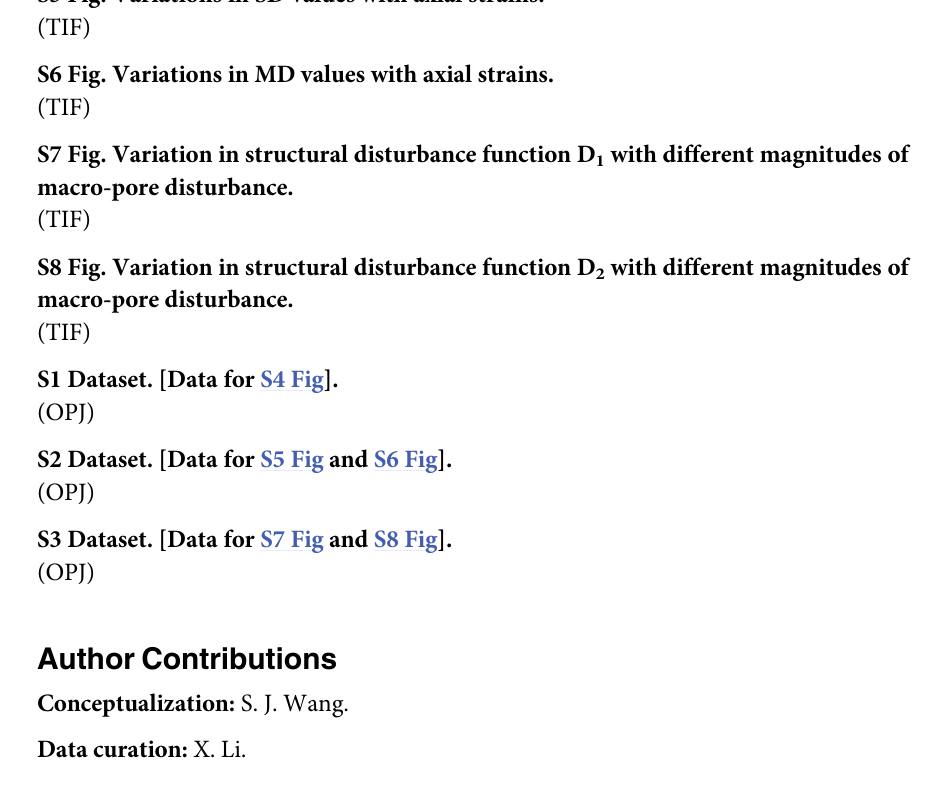
S2 Fig. The position arrangement of scanned sections. S3 Fig. The CT scanned images for Samples A to E taken at Section c during the triaxial shear- ing test (Left to right: axial strain = 0%, 5%, 10%, and 15%, respectively; Top to bottom: Sam- ples A, B, C, D, and E, respectively). S4 Fig. The relationship between deviator stress q , volumetic strain ε and axial strain ε v a (i.e., q = σ with σ = the axial stress and σ = the radial stress , respectively; the radial 1 − σ 3 1 3 stress σ = confining pressure also). 3 S5 Fig. Variations in SD values with axial strains. S6 Fig. Variations in MD values with axial strains. S7 Fig. Variation in structural disturbance function D with different magnitudes of 1 macro-pore disturbance. S8 Fig. Variation in structural disturbance function D with different magnitudes of 2 macro-pore disturbance. S1 Dataset. [Data for S4 Fig]. S2 Dataset. [Data for S5 Fig and S6 Fig]. S3 Dataset. [Data for S7 Fig and S8